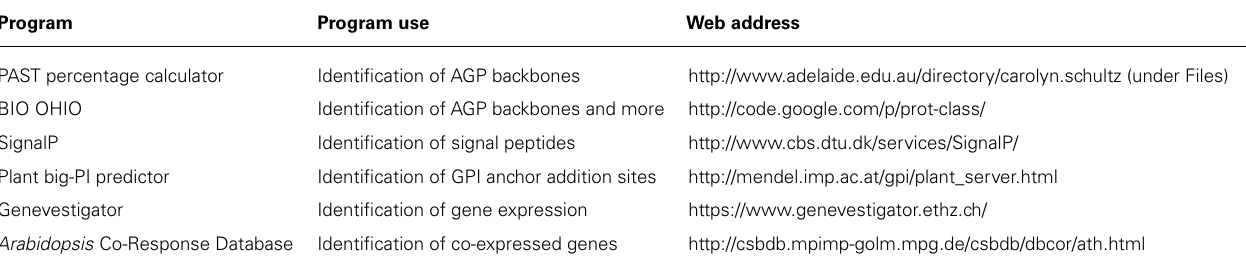
Table 1 | Bioinformatic programs used to identify and characterizeAGPs. Program